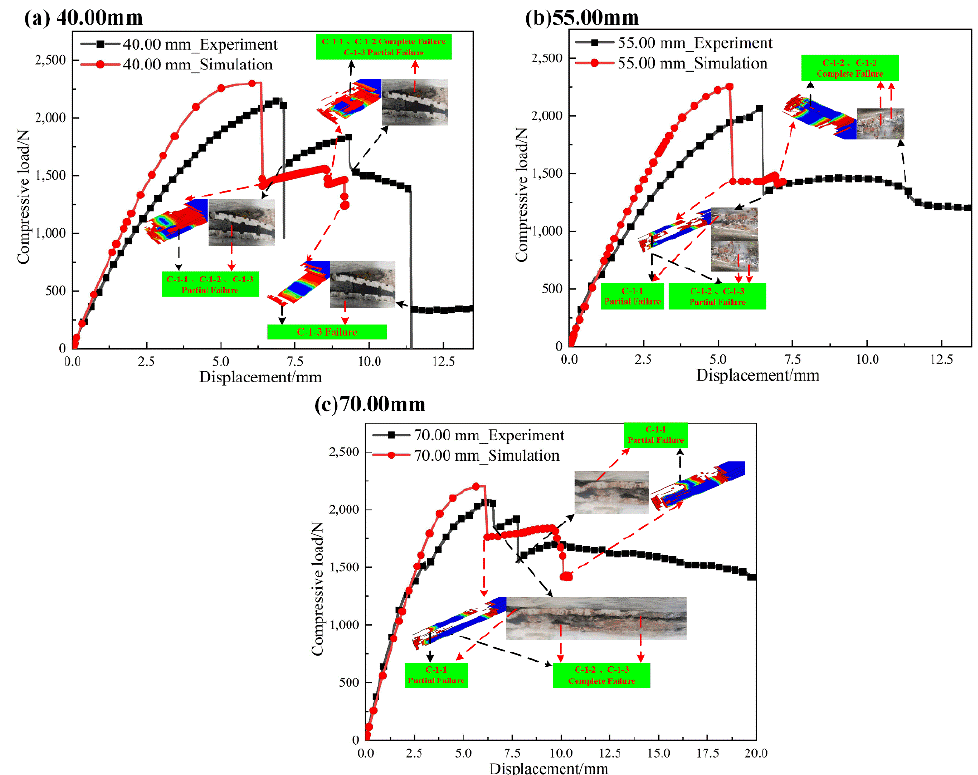
Figure 13. Load–displacement curves for L-joints with different bonding lengths: ( a ) 40.00 mm, ( b ) 55.00 mm and ( c ) 70.00 mm.